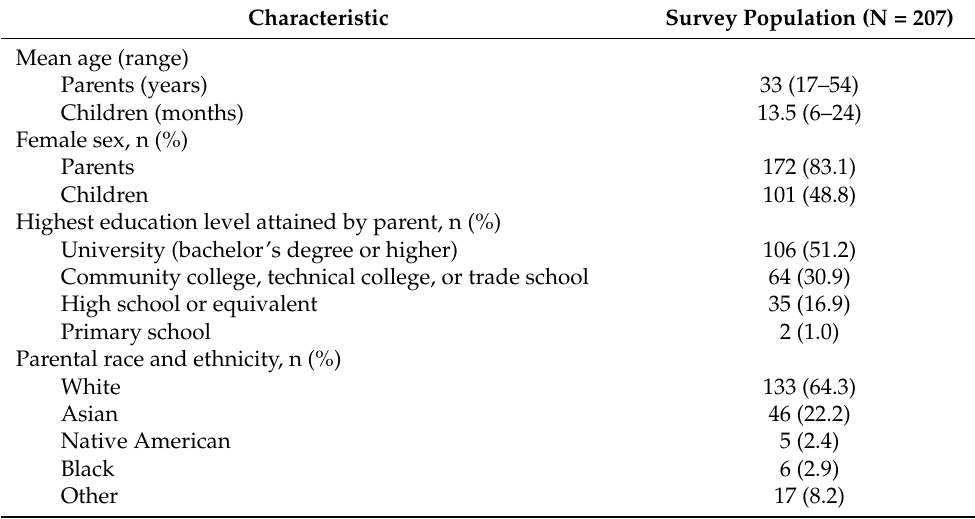
Table 1. Sociodemographic characteristics. Characteristic Survey Population (N =